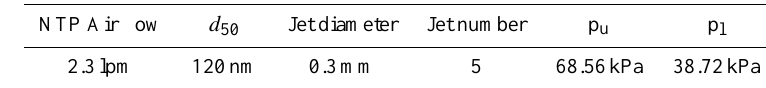
Table 1. The operational parameters for the impactor, p u and p l are the pressures above and below the jet stage, respectively and d 50 is the 50% collection efficiency cutpoint of the impactor as calibrated.